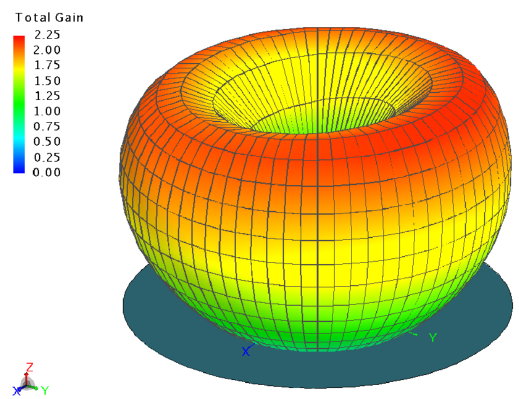
Figure 8. Far-field radiation pattern of TF model